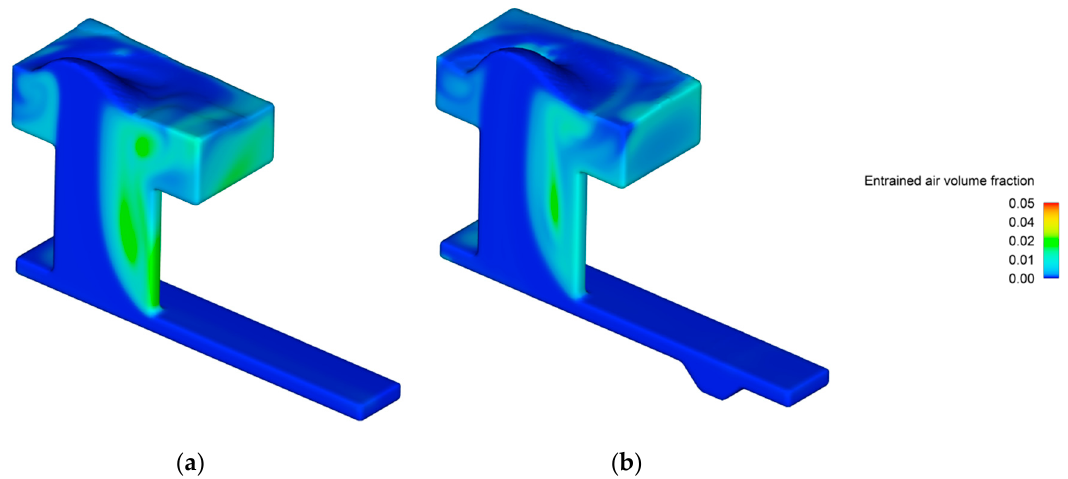
Figure 6. Entrained air volume fraction profiles at t = 2 s for the ( a ) basic running system (BRS) and ( b ) low placed filter (LPF) designs.